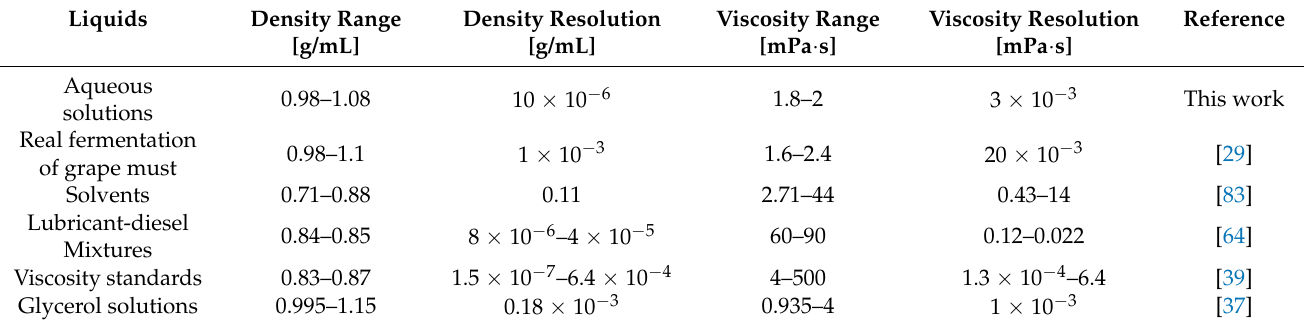
Table 5. Density and viscosity resolution compared with other